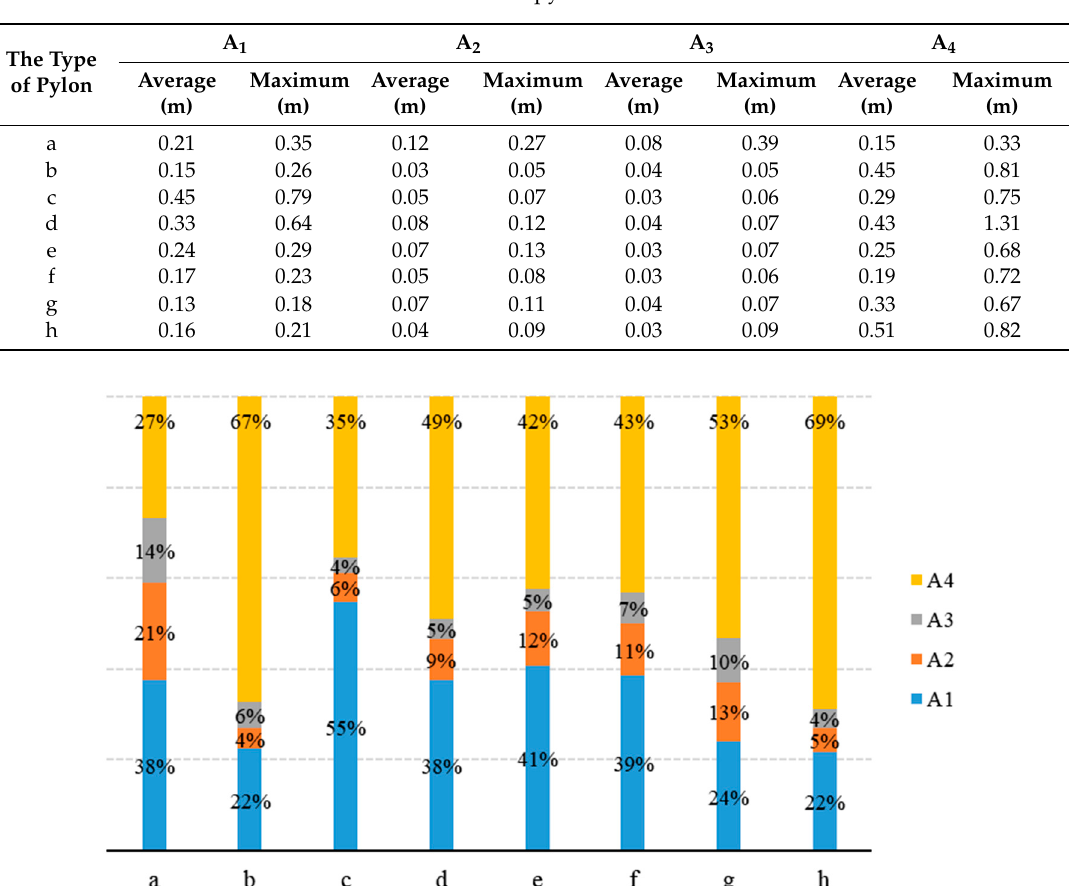
Table 10. Errors in the pylon reconstruction.